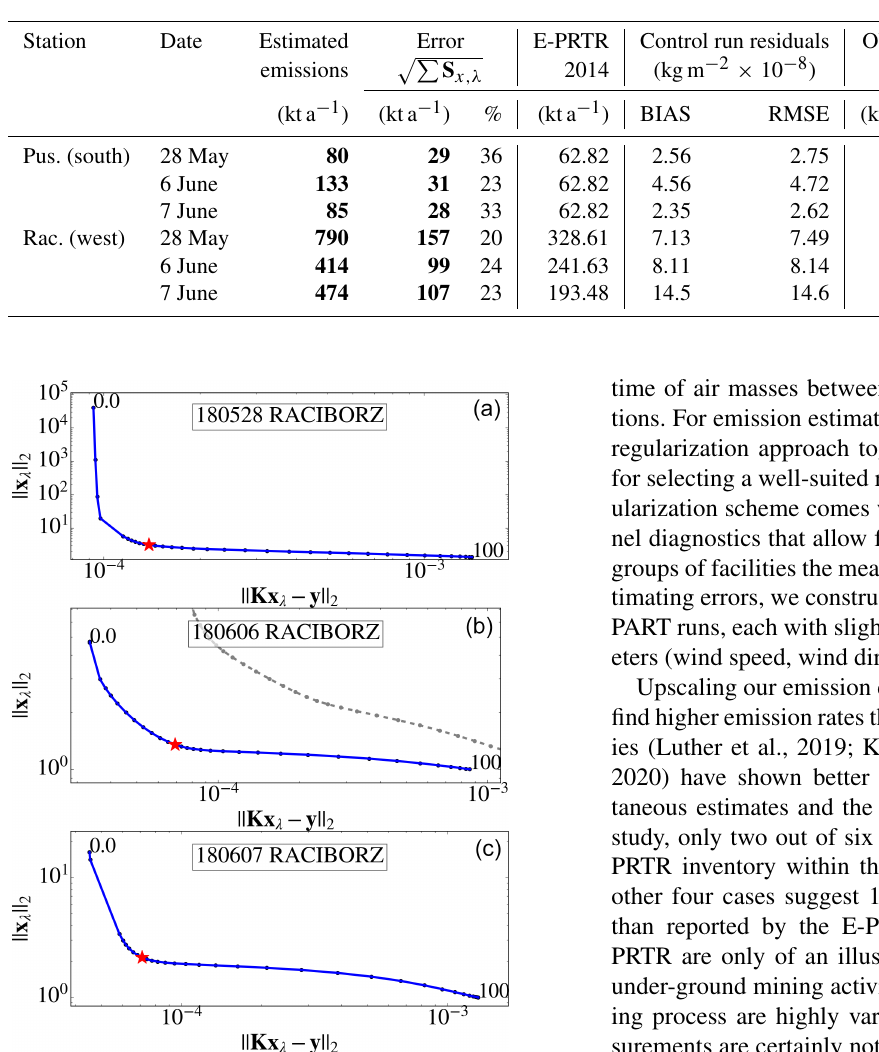
Table 2. Overview of all case studies including respective emission sums and their errors (bold numbers). Mean bias and root mean square error (RMSE) of the CONTROL run residuals refer to the regularized solution. The errors due to observational uncertainties and due to background methane variability are listed in the last four columns.